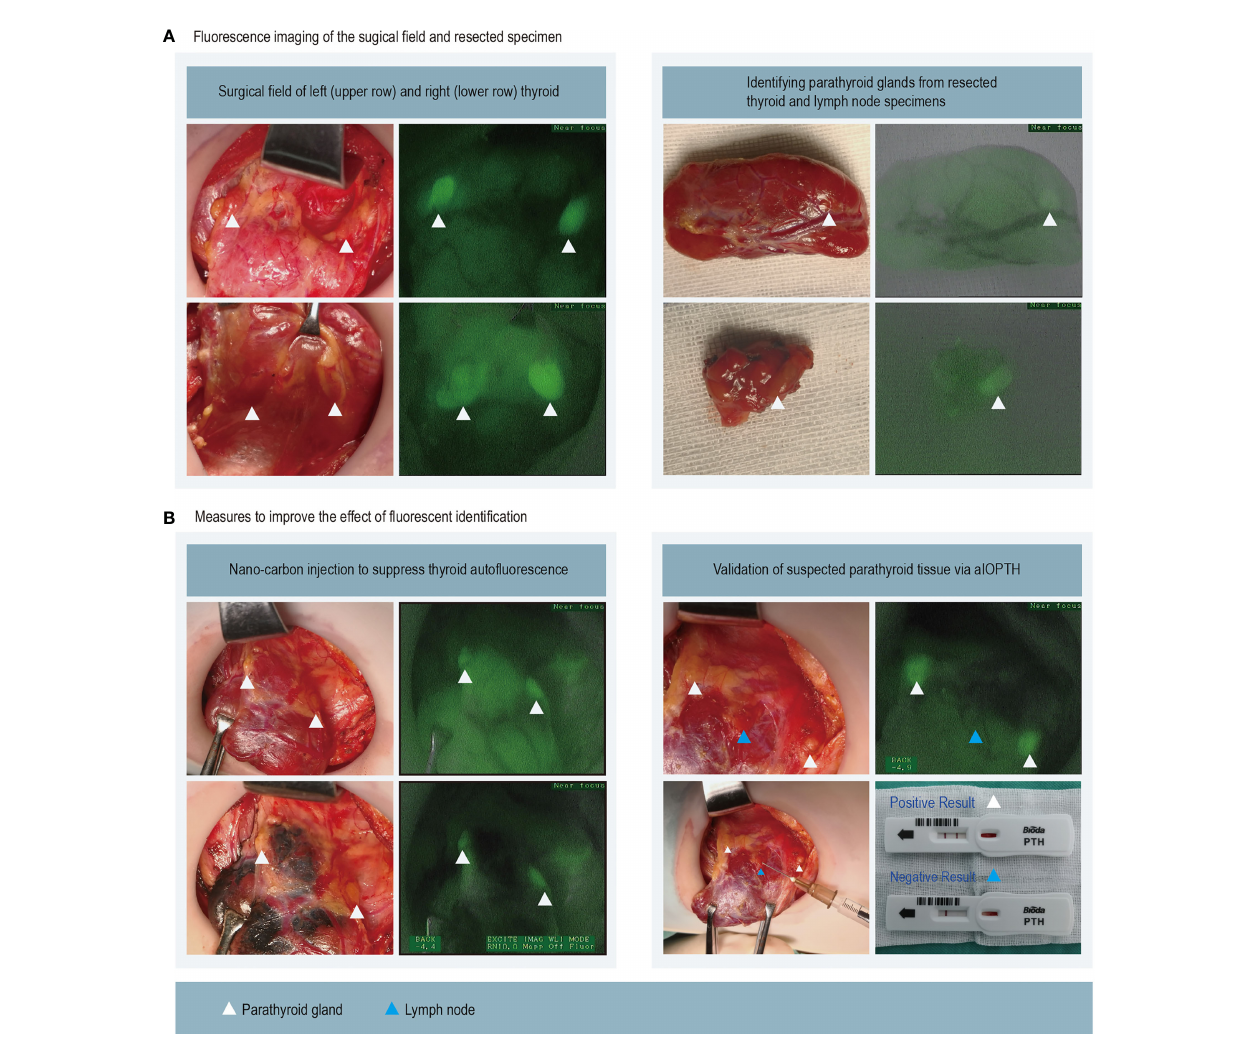
FIGURE 1 | We used fl uorescence imaging of the surgical fi eld and resected thyroid and lymph nodes specimens to locate the parathyroid gland. Parathyroid tissues can be highlighted as green in the images (A) . Nano-carbon can suppress the fl uorescence of the thyroid gland and thus make it easier to recognize parathyroid glands. The lymph node (blue triangle) was visually recognized as the parathyroid gland, but it had weak fl uorescence and was fi nally excluded via aIOPTH (B)